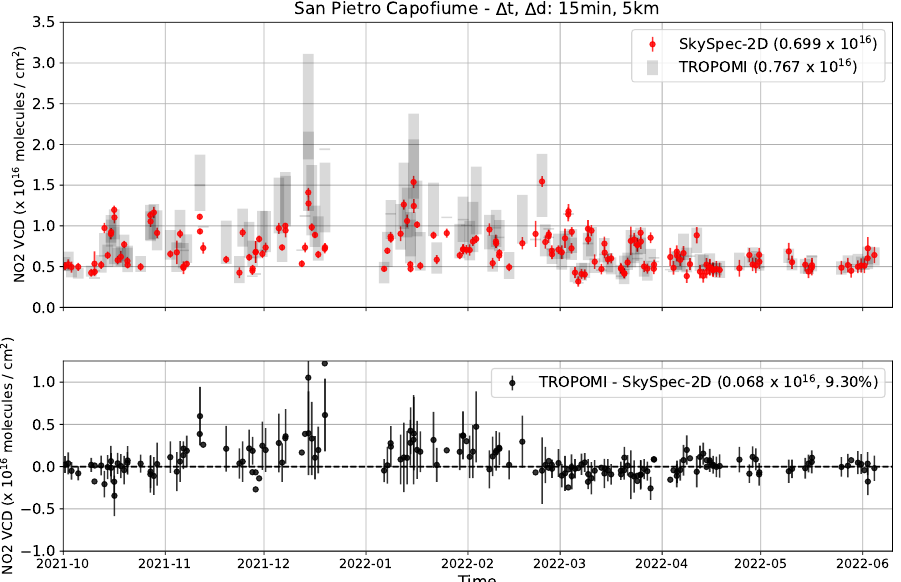
Figure 11. NO 2 VCDs retrieved from SkySpec-2D (in red) and TROPOMI (grey shadows) at the “Gior- gio Fea” observatory in SPC. SkySpec-2D data are averaged in 15 min around the S-5P overpass time. The TROPOMI shadows represent the mean values within the 5 km radius with standard